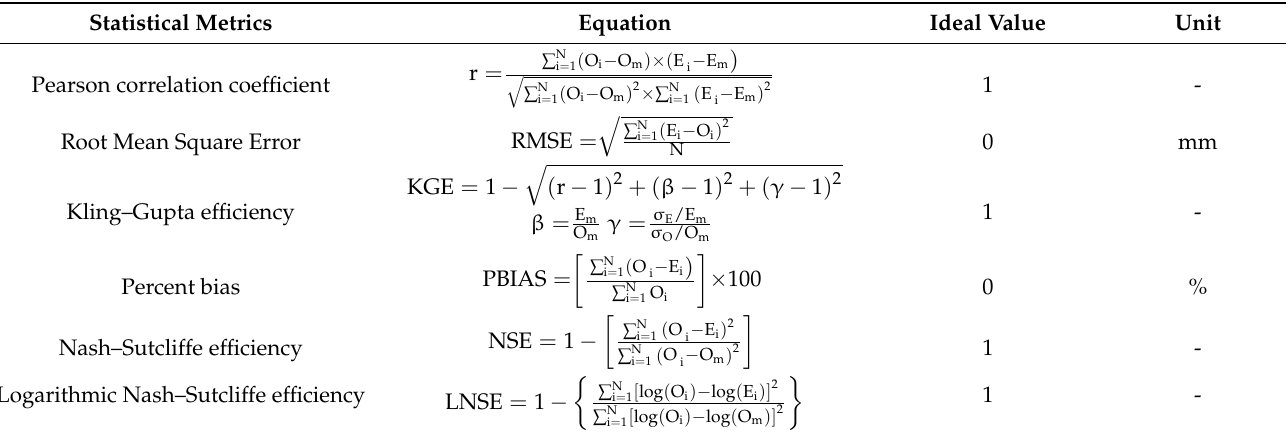
Table 1. Statistical metrics used to evaluate the performance of precipitation and hydrological modeling with reanalysis products for the